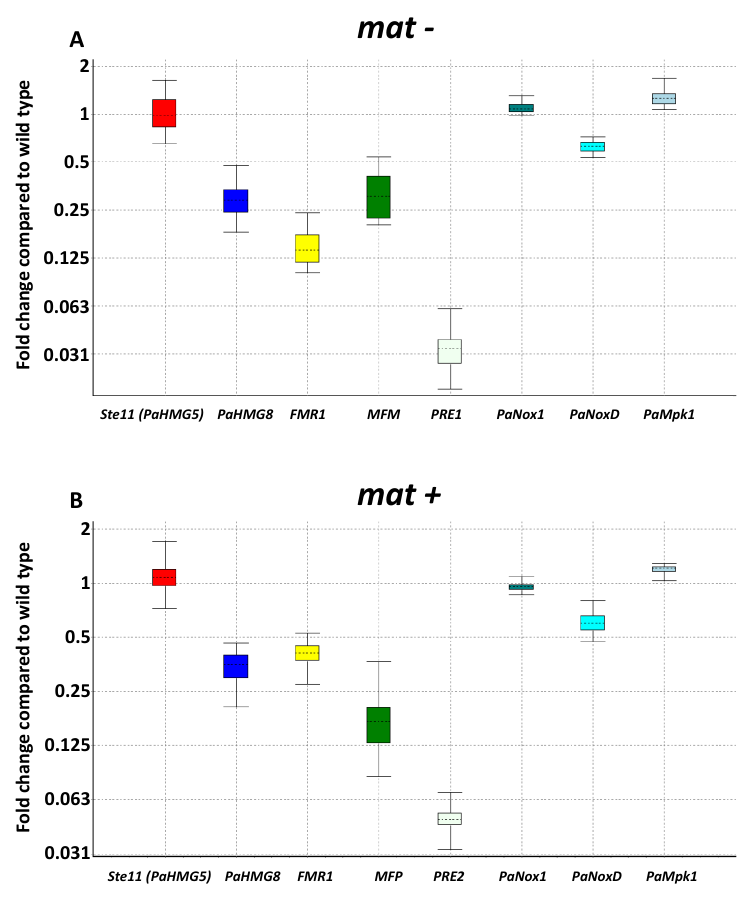
Figure 4. RT-qPCR expression of selected genes in ∆ pro1 mutants. ( A ) PaPro1 ∆ mat − versus wild type mat − . Normalization genes selected with geNorm are CIT1 , GPD and TBP , with an average stability value M = 0.08 and V 3/4 = 0.025 (Table_SI_3_geNorm). ( B ) PaPro1 ∆ mat+ versus wild type mat+ . Normalization genes selected with geNorm are CIT1 , GPD and TBP , with an average stability value M = 0.10 and V 3/4 = 0.024 (Table_SI_3_geNorm). Expression ratios of the following genes have a p -value below 1% and their CI 95% does not include 1: HMG8 , mating-type genes ( FMR1 , FPR1 ), pre-propheromone genes ( MFM , MFP ), pheromone-receptor genes ( PRE1 , PRE2 ), PaNoxD and PaMpk1